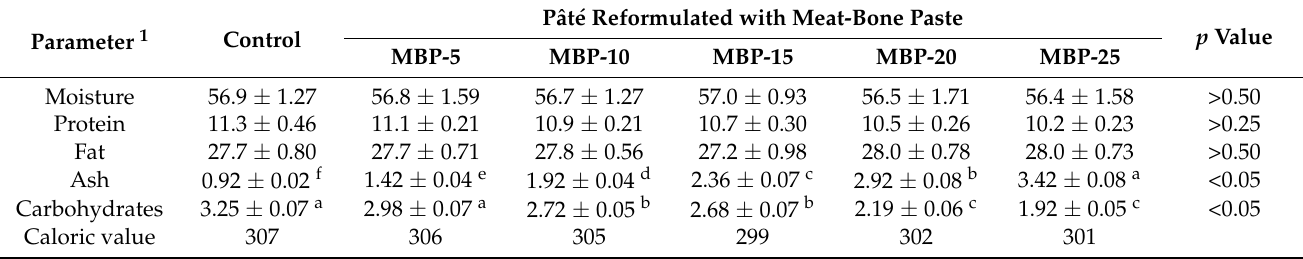
Table 4. Chemical composition of liver p â t é s with meat-bone